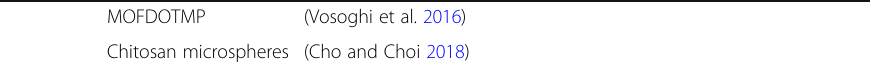
Table 1 Representative examples of carriers that have been loaded or conjugated to holmium and to the dysprosium/holmium generator (Continued)